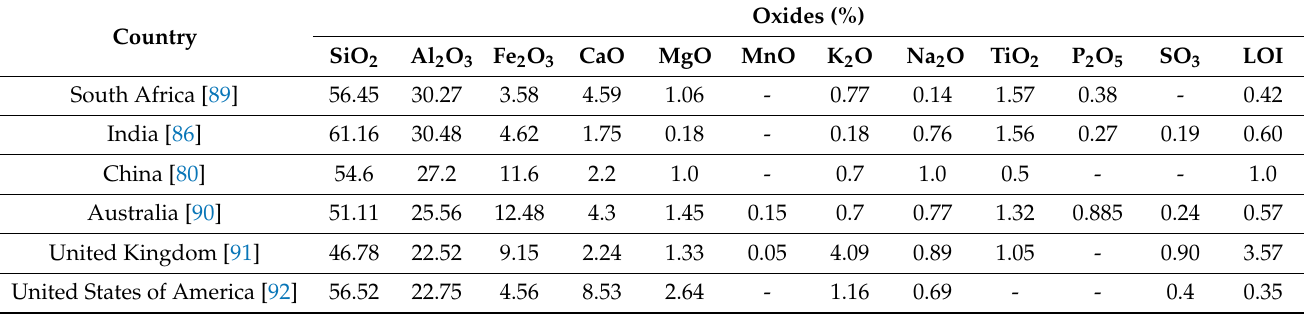
Table 2. Chemical composition of fly ash in different areas of the world.